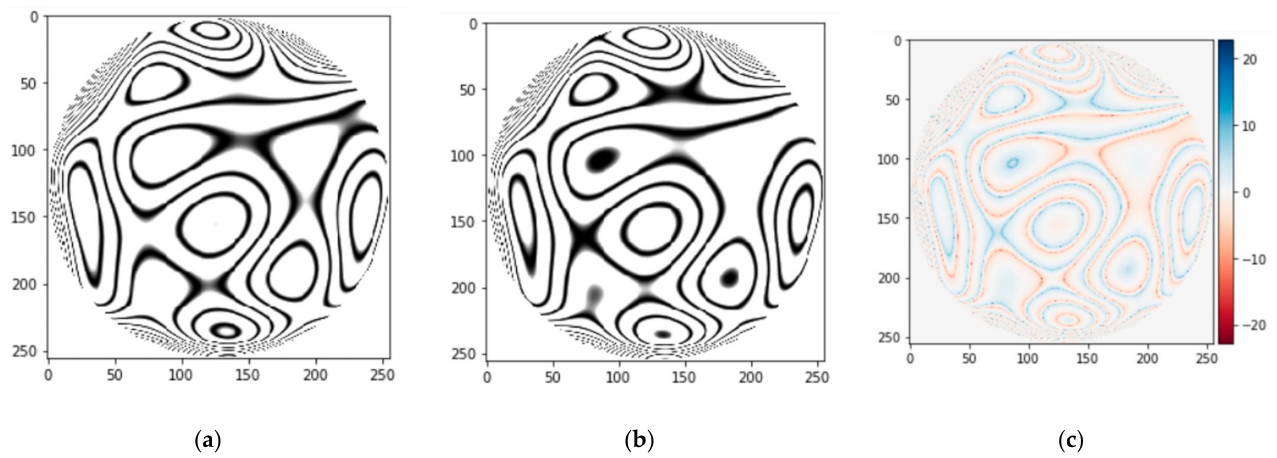
Figure 6. The ideal images of interference fringe. ( a ) The phase shift is zero. ( b ) The phase shift is π /4. ( c ) The input image of the Generator according to Equation